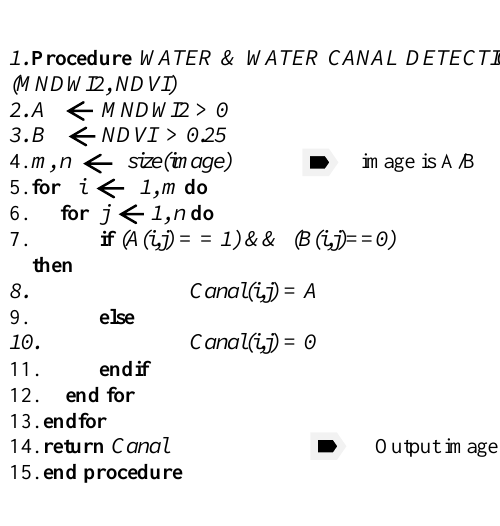
Figure 2: Block diagram of